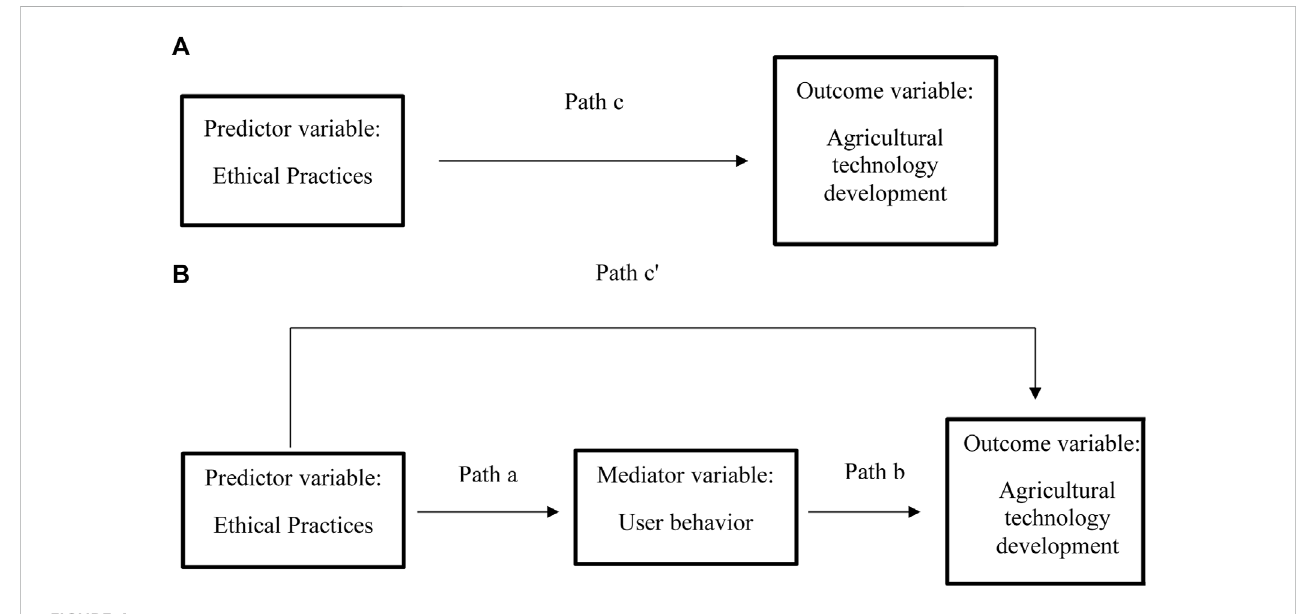
FIGURE 4 Diagrams of paths in the hypothesized mediational model.